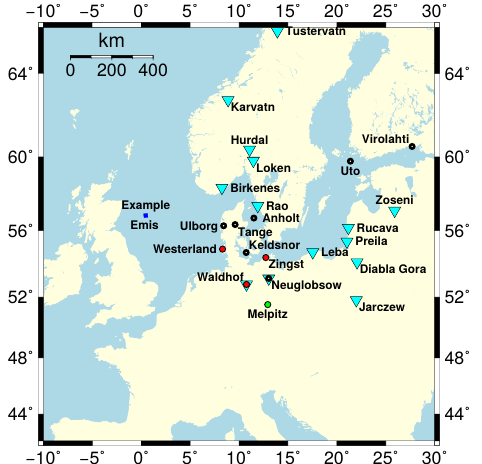
Figure 6. Locations of the AERONET stations at which measured and modeled hourly AOD data were compared. Red circles: in addi- tion to statistical data being provided, plots are shown and described in detail. Orange: statistical metrics are only shown in the Supple- ment (Table